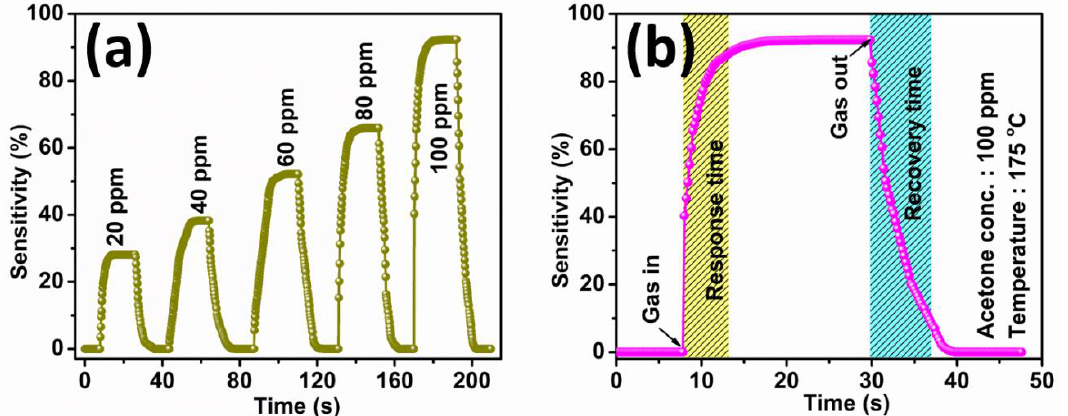
Figure 5. ( a ) Transient characteristics at 175 °C and ( b ) response and recovery time calculation of ZnS QDs based acetone sensor.